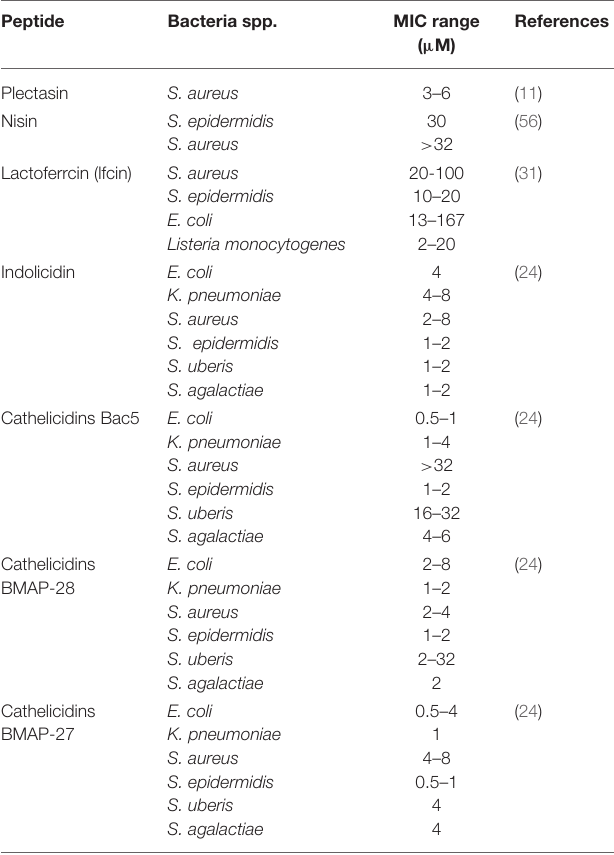
TABLE 2 | Antimicrobial activity of the peptide-based antimicrobial compound against pathogenic bacteria isolated from livestock. Peptide Bacteria